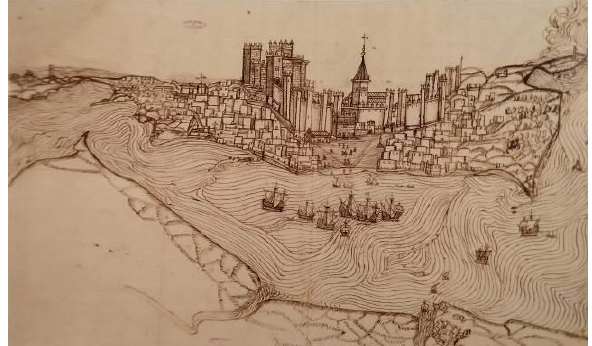
Figure 4. Bay Sea. Puerta Tierra drawing by Tiburzio Spannocchi in 1587. AGS. Secretary of War, File, 03352, 90,